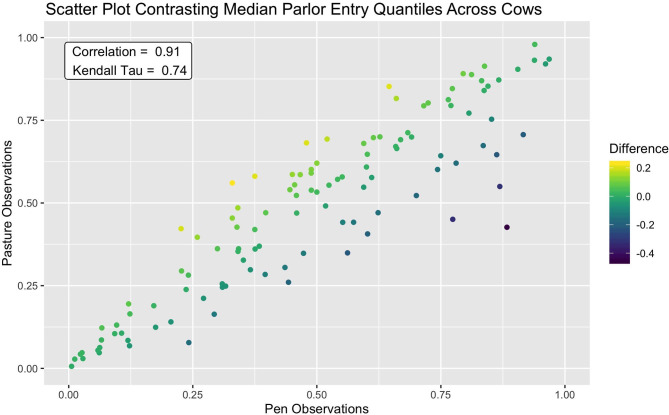
Scatter plot showing strong agreement of median parlor entry quantiles between the pen and pasture subperiods. A small portion of cows which demonstrated a larger shift in entry position moved forward in the queue after the shift to pasture from pen.